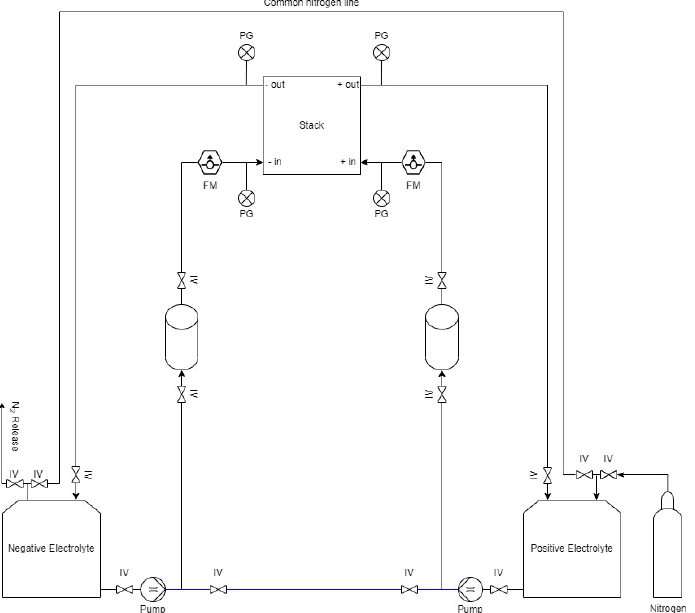
Figure A1. Piping and instrumentation diagram of the VRFB system showing the locations of pressure gauges (PG), isolation valves (IV), and flowmeters (FM)